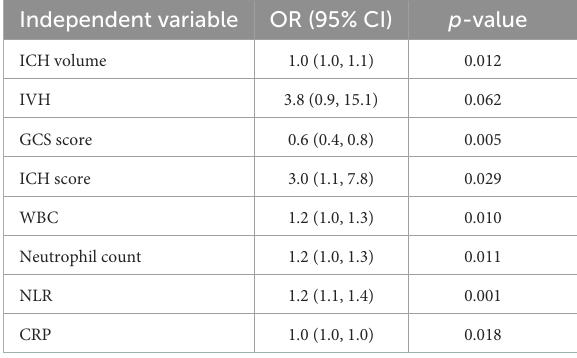
TABLE 2 Risk factors associated with 30-day